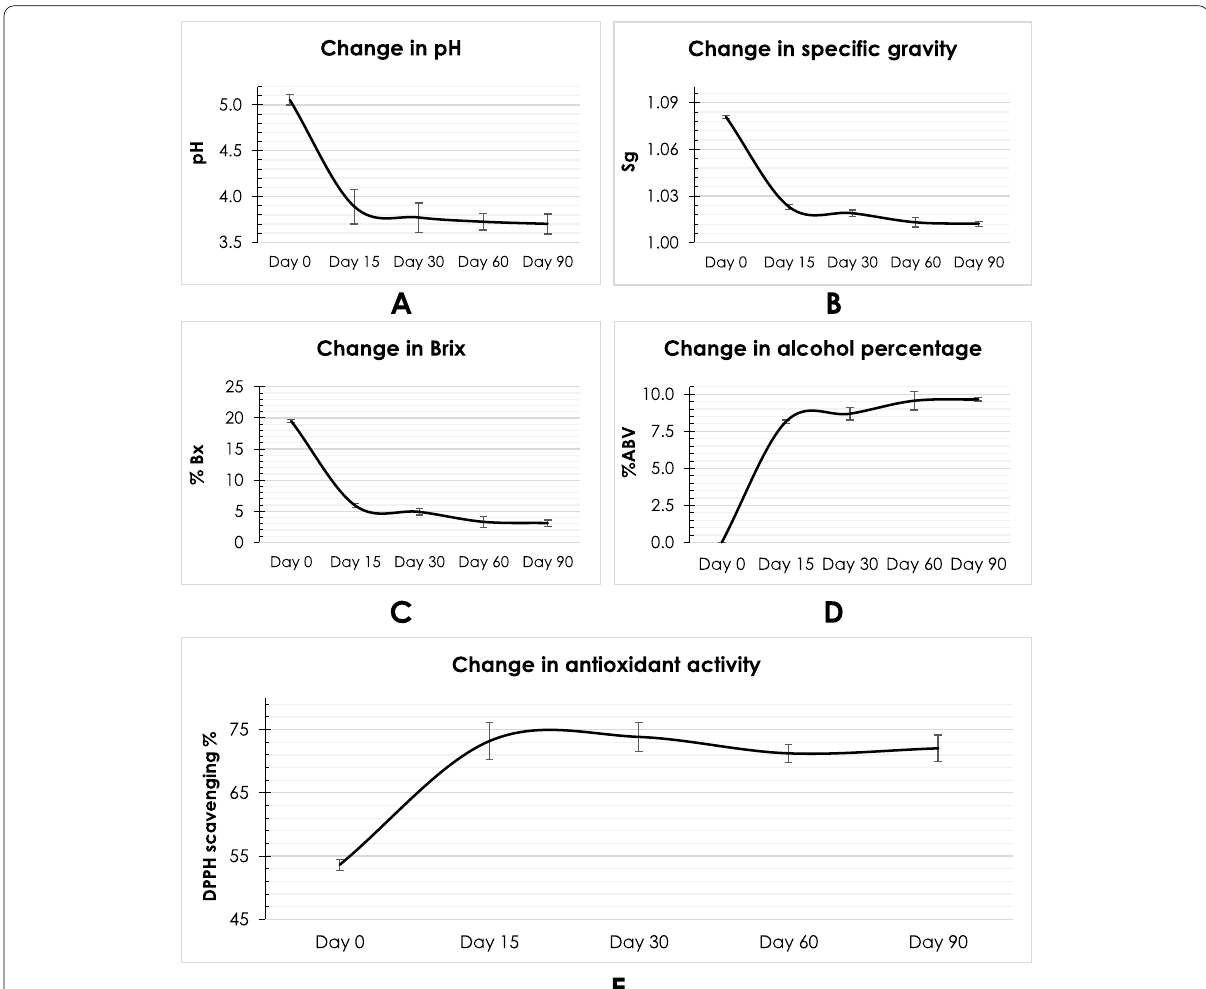
Fig. 8 Alteration in properties of Camellia japonica petal wine (CJPW) during aging. A pH; B Specific gravity (Sg); C Brix (%Bx); D Alcohol by volume (%ABV); E Antioxidant activity (DPPH